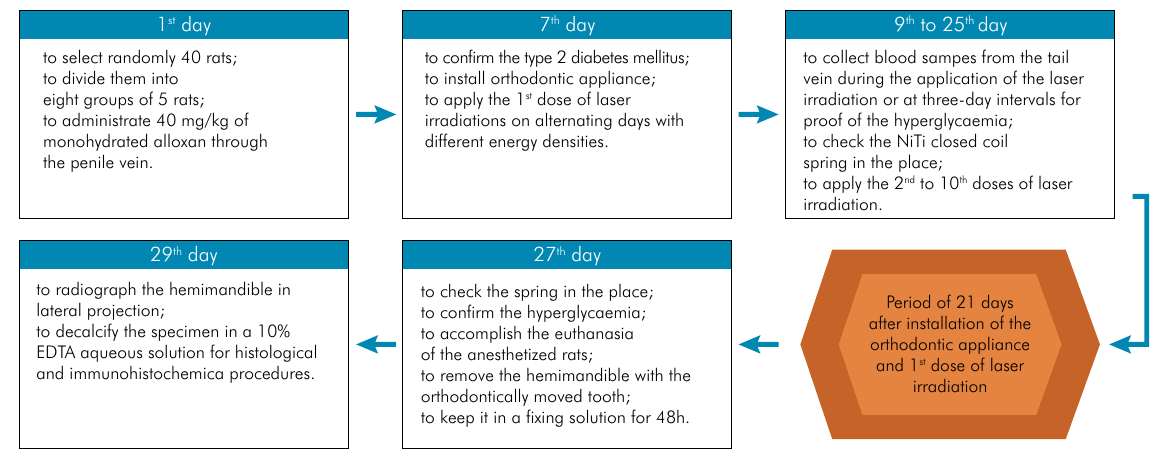
Figure 3. Flowchart showing the sequential timing of the experimental steps for each studied